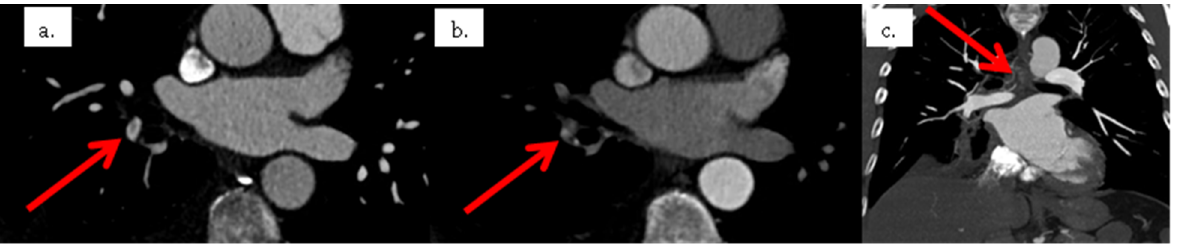
Figure 4. Second CT scan with two acquisition times. ( a ) shows axial early-acquisition CT with a segmental filling defect in a segmental artery of the right lower lobe. ( b ) shows axial late acquisition CT with, instead of a filling defect, the high enhancement of the same segmental pulmonary artery and of the bronchial arteries, while the other pulmonary arteries were not enhanced. ( c ) shows a coronal maximum intensity projection reformat of the late acquisition CT. It shows dilated systemic bronchial arteries feeding the right inferior lobar pulmonary neoplastic.